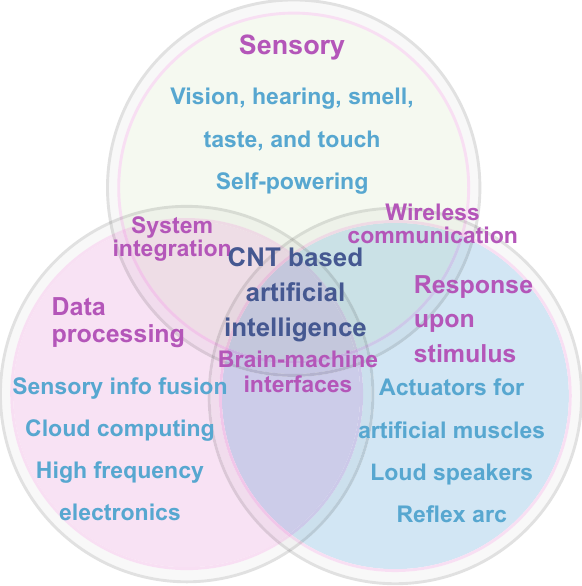
Fig. 2 The system integration of carbon nanotubes-based artificial intelligence. Three kinds of devices compose the system, including the Internet of Things-based sensory, data processing, and